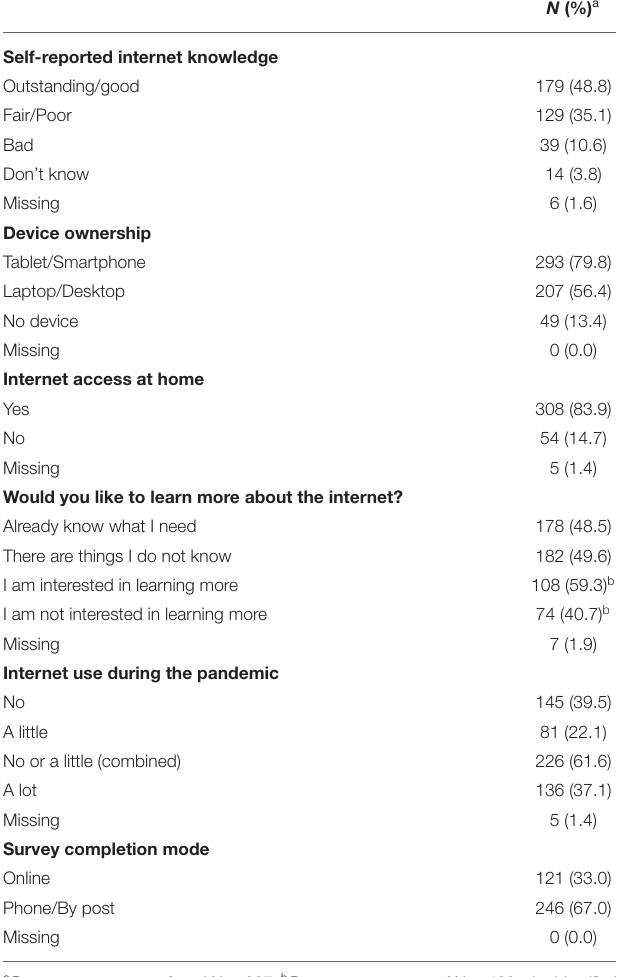
TABLE 2 | Digital engagement characteristics ( N =